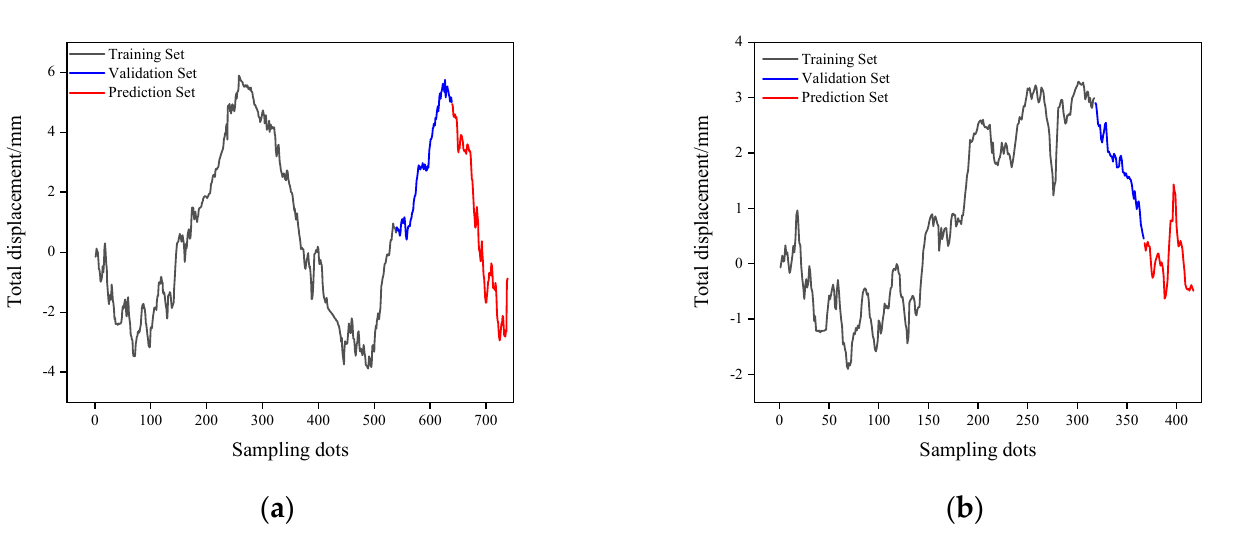
Figure 6. Deformation monitoring data graph(( a ) EX5, ( b ) EX2). Table 1. Division of measuring point data